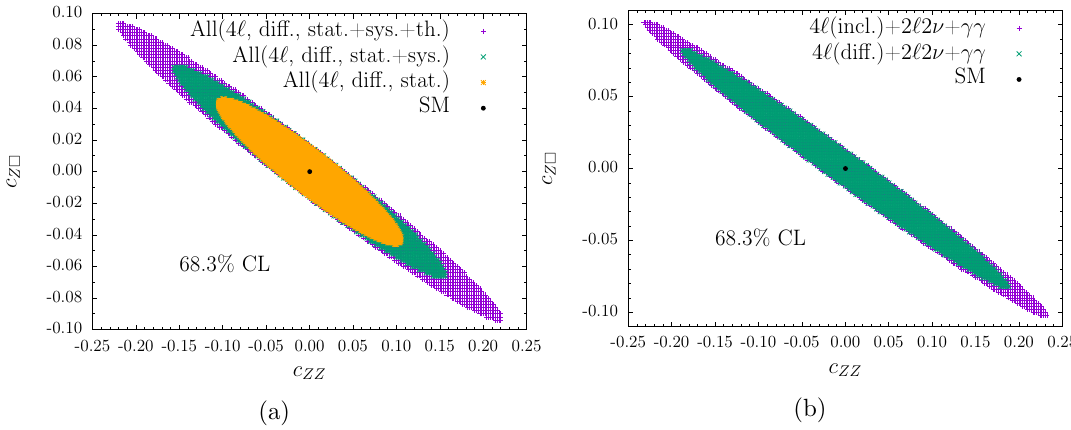
Figure 8. (a) E(cid:11)ect of various uncertainties on the (cid:12)t when di(cid:11)erential information in the 4 ‘ channel is used. (b) A comparison of inclusive (purple) and di(cid:11)erential (green) information for H 4 ‘ in the (cid:12)t when data in other decay channels are also included. In each decay mode, all the ! relevant production channels are taken into